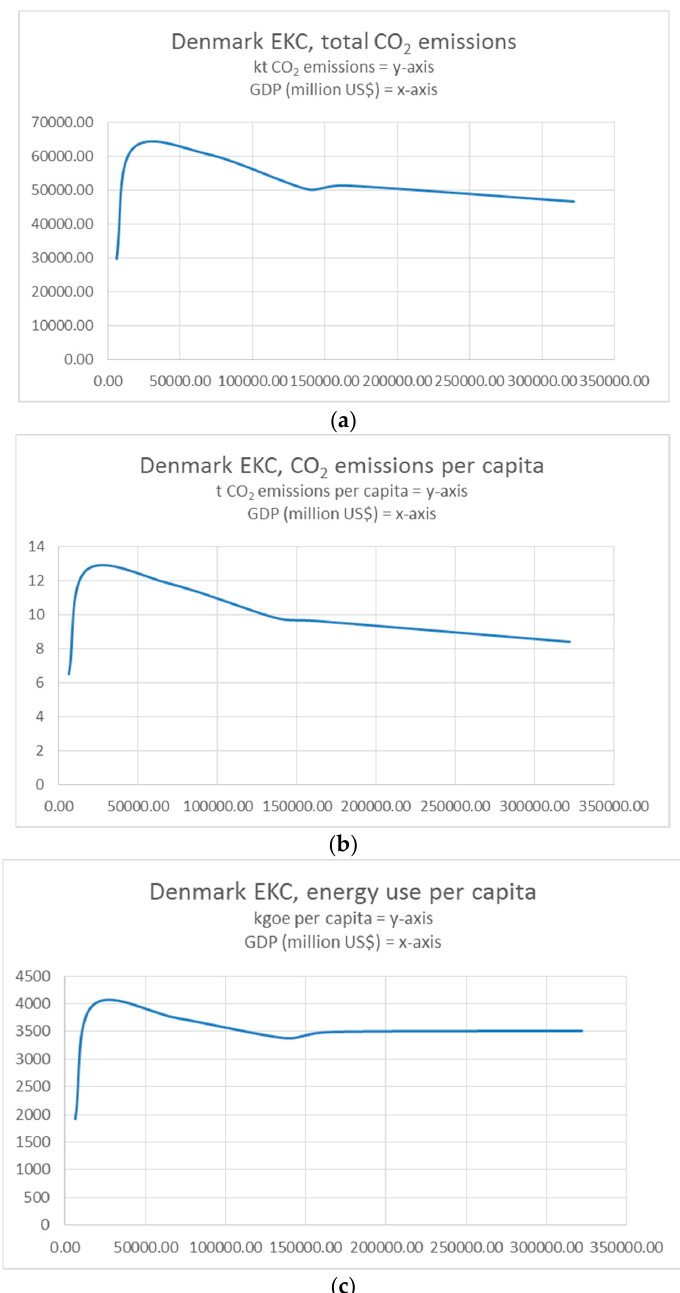
Figure 5. Analysis of the EKC for Denmark. Data source: [44]. ( a ) Denmark EKC, total CO 2 emissions; ( b ) Denmark EKC, CO 2 emissions per capita; ( c ) Denmark EKC, energy use per capita.